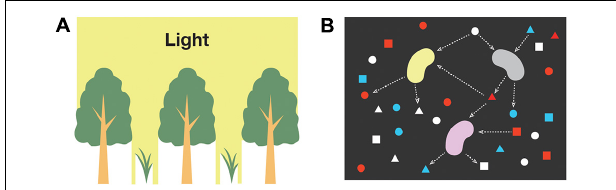
( reaction 1 : the overall